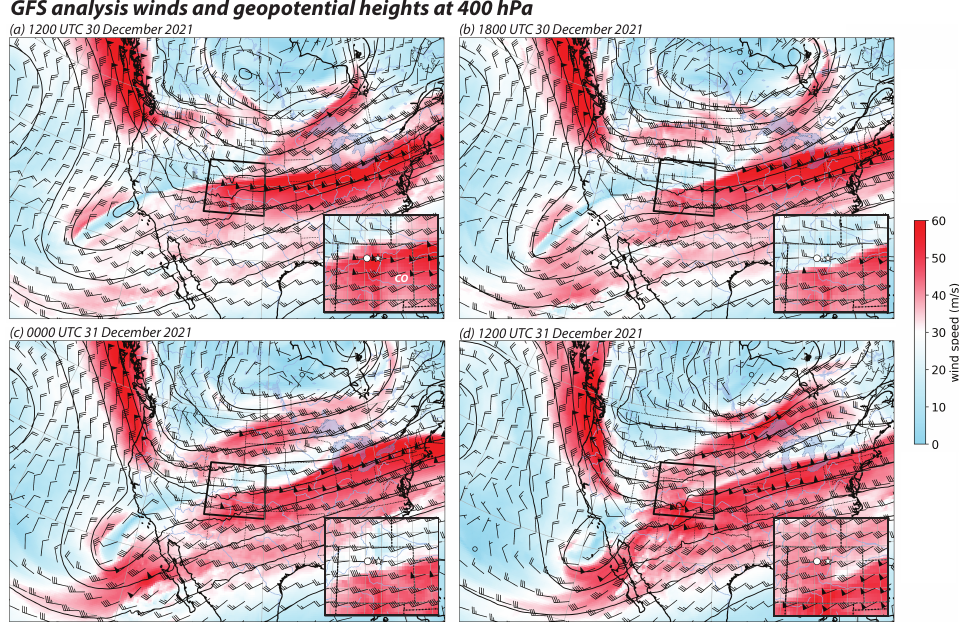
Figure 3. 400 hPa winds (m/s) and geopotential heights (60 gpm contours) for four times during the windstorm made using GFS analyses (00 h forecasts), including ( a ) 1200 UTC 30 December, ( b ) 1800 UTC 30 December, ( c ) 0000 UTC 31 December, and ( d ) 1200 UTC 31 December, all in 2021. Black rectangles mark location of insets, which focus on state of Colorado and surrounding area. In insets, the star represents Boulder and the circle identifies location selected to represent the upstream